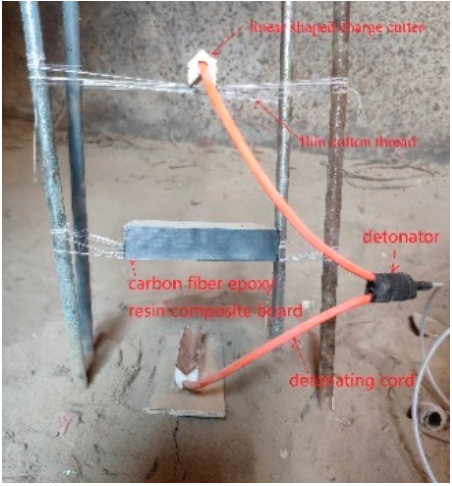
Figure 15. Experimental device.